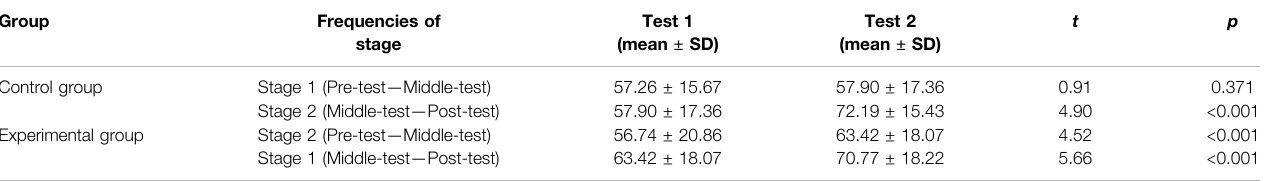
TABLE 5 | Different group students ’ performance of scienti fi c creativity in different stages (control group n (cid:1) 31; experimental group n (cid:1) 31).